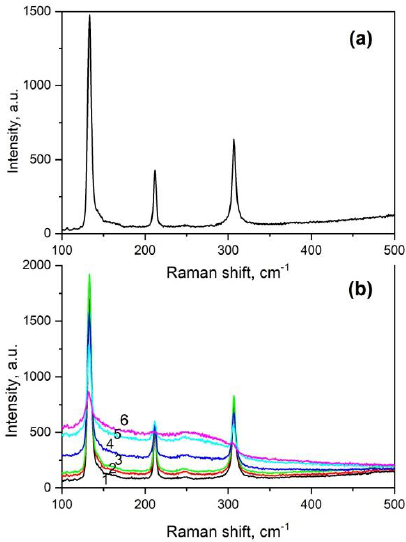
Figure 11. Raman spectra for single crystal GaSe ( a ) and from the surface of GaSe with an ARM ( b ), obtained at an excitation of 532 nm, with the following parameters (pulse energy and number of pulses): 5.8 nJ/N = 1; 5.8nJ/N = 8; 8.4nJ/N = 8; 15.8 nJ/N = 8; 23.4 nJ/N = 8; and 37.5 nJ/N = 8 (curves 1 − 6,